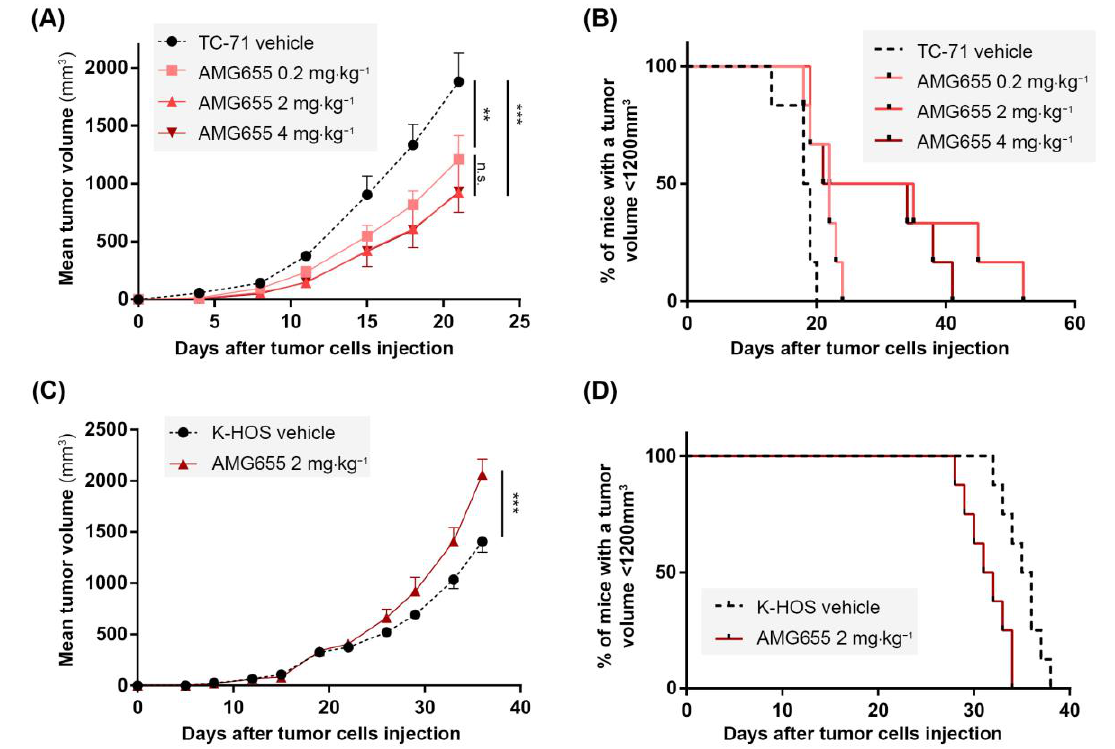
Figure 2. In vivo, AMG655 slows down the primary tumor growth of the Ewing sarcoma model induced by TC-71 cells sensitive to rhTRAIL but accelerates the osteosarcoma model tumor pro- gression induced by resistant K-HOS cells. Four groups of six mice were injected with 1 × 10 6 TC-71 cells as described in the “Materials and Methods” section. Mice of each group were injected twice a week with 0, 0.2, 2, or 4 mg · kg − 1 of AMG655. ( A ) Average tumor volume per group. ( B ) Per- centage of mice with a tumor volume below 1200 mm 3 for the three groups. Two groups of seven mice were injected with 1 × 10 6 K-HOS cells. Each group was injected twice a week with 0 or 2 mg · kg − 1 of AMG655. ( C ) Average tumor volume per group. ( D ) Percentage of mice with a tumor volume below 1200 mm 3 for the two groups. (** p < 0.01, *** p <